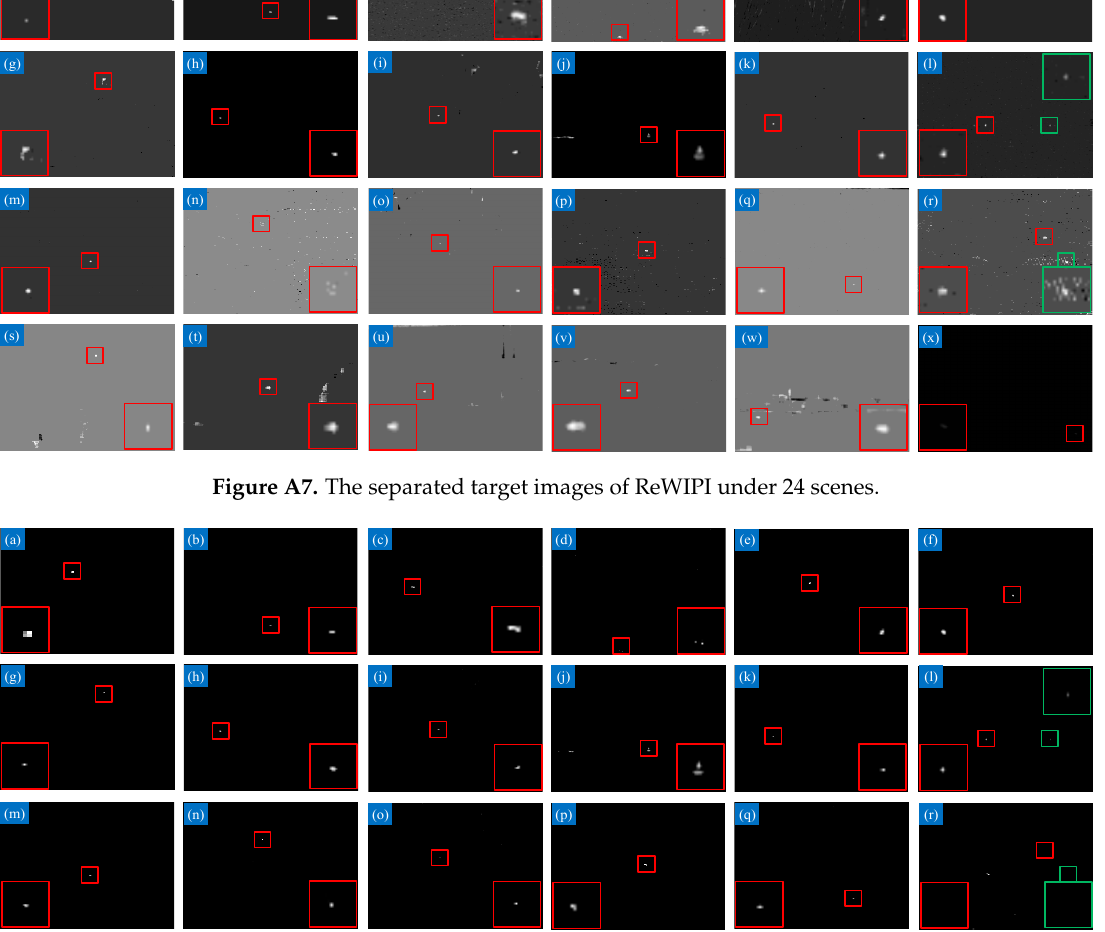
Figure A6. The separated target images of NIPPS under 24 scenes.